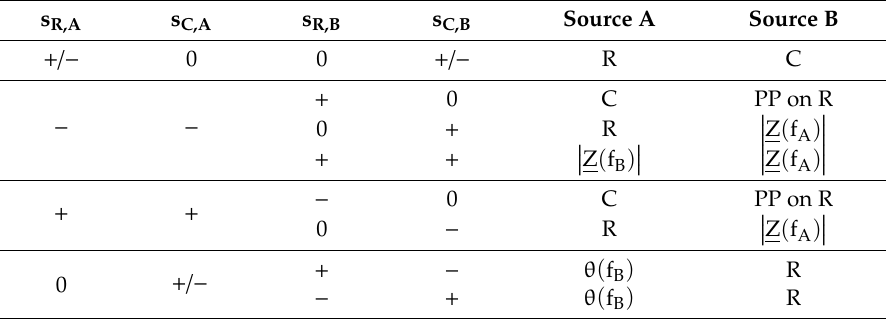
Table 1. Truth table for the selection of the output electrical